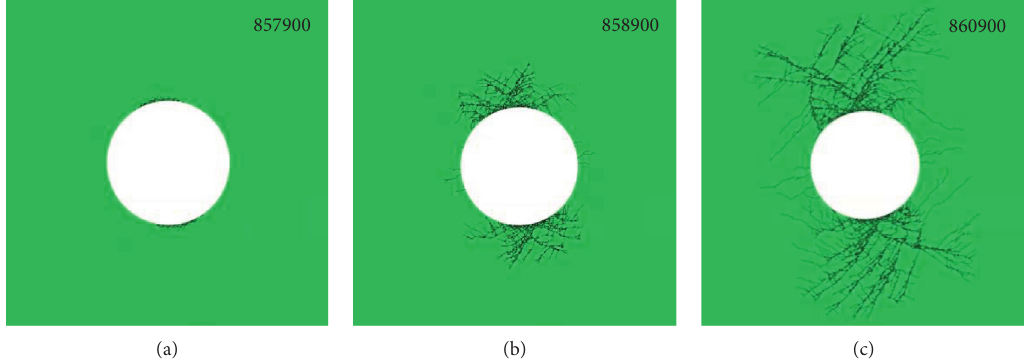
Figure 12: The simulated crack propagation process in studying the constitutive